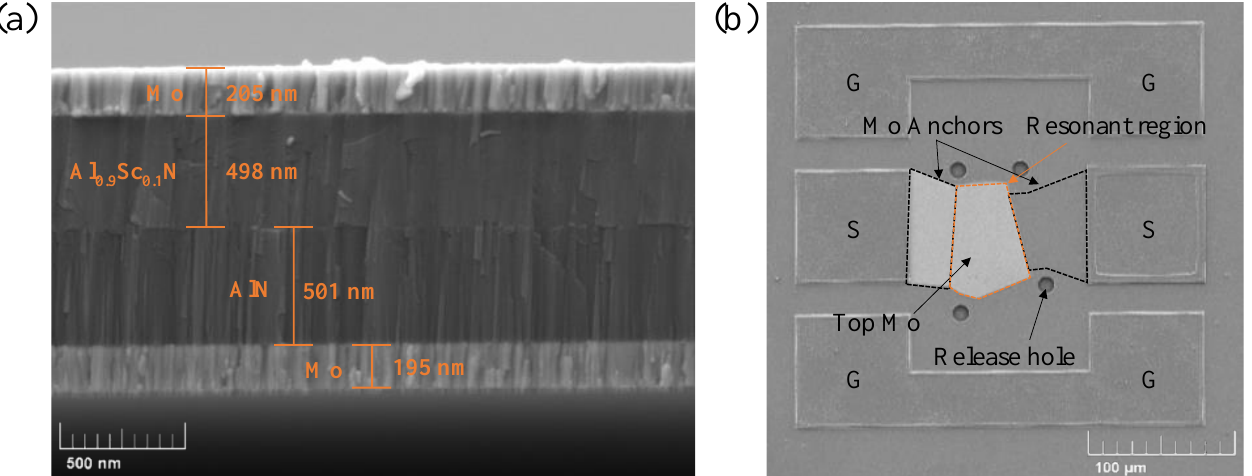
Figure 5. Characterization of piezoelectric film and FBAR device. ( a ) Cross-sectional view of AlN/Al 0.9 Sc 0.1 N composite film consisting of 500 nm-thick AlN and 500 nm-thick Al 0.8 Sc 0.2 N. ( b ) Vertical view of fabricated FBAR based on the AlN/Al 0.9 Sc 0.1 N composite film consisting of 500 nm-thick AlN and 500 nm-thick Al 0.8 Sc 0.2 N. The signal and ground pads are marked with “G” and “S” labels, respectively.